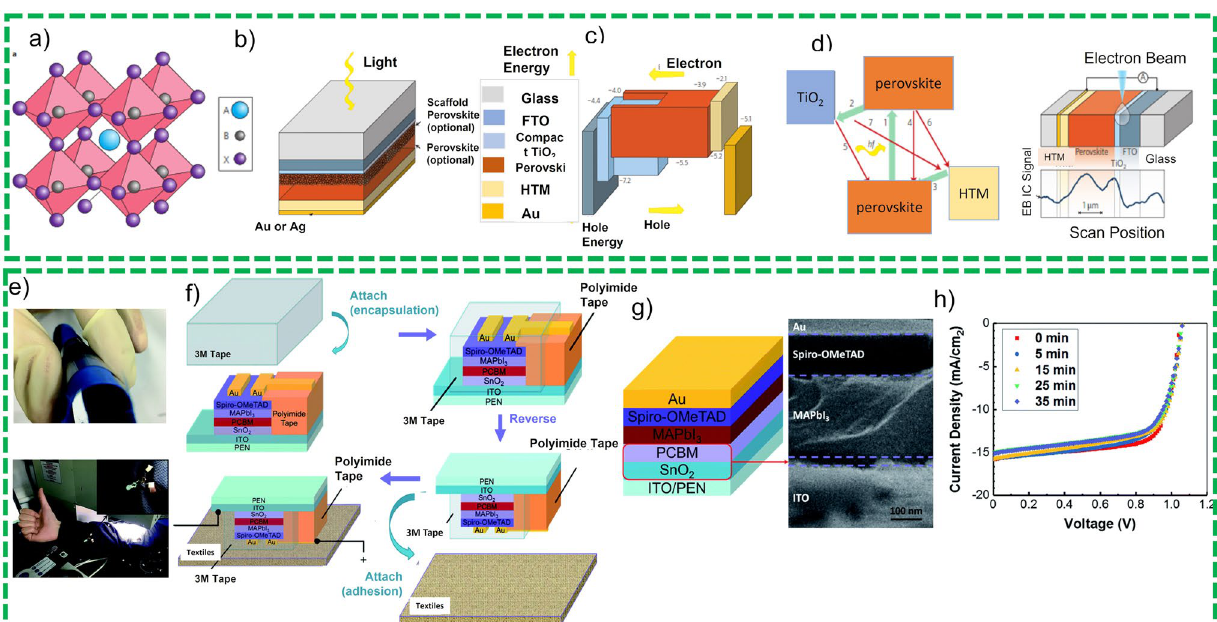
Fig. 7 a Cubic crystalline structure of perovskite solar cell, here the bulky cation A is typically the methylammonium ion (CH 3 NH 3 ), the minor cation B is Pb, and the anion X is a halogen ion (typically I, but both Cl and Br), b typical structure of perovskite solar cell, c vacuum energy level for constituents’ active materials, d demonstration of electron transfer process in the perovskite solar cell and pictorial demonstration of EBIC process. Reprinted with permission from the Ref. [70]. e Photograph of textile substrate-based perovskite solar cell, f graphic interpreta- tion of development process of perovskite solar cells through functionalized encapsulation, g device structure and cross-sectional SEM view of the fabricated device, h J–V graph of the textile substrate-based perovskite solar cell with respect to immersing time in water